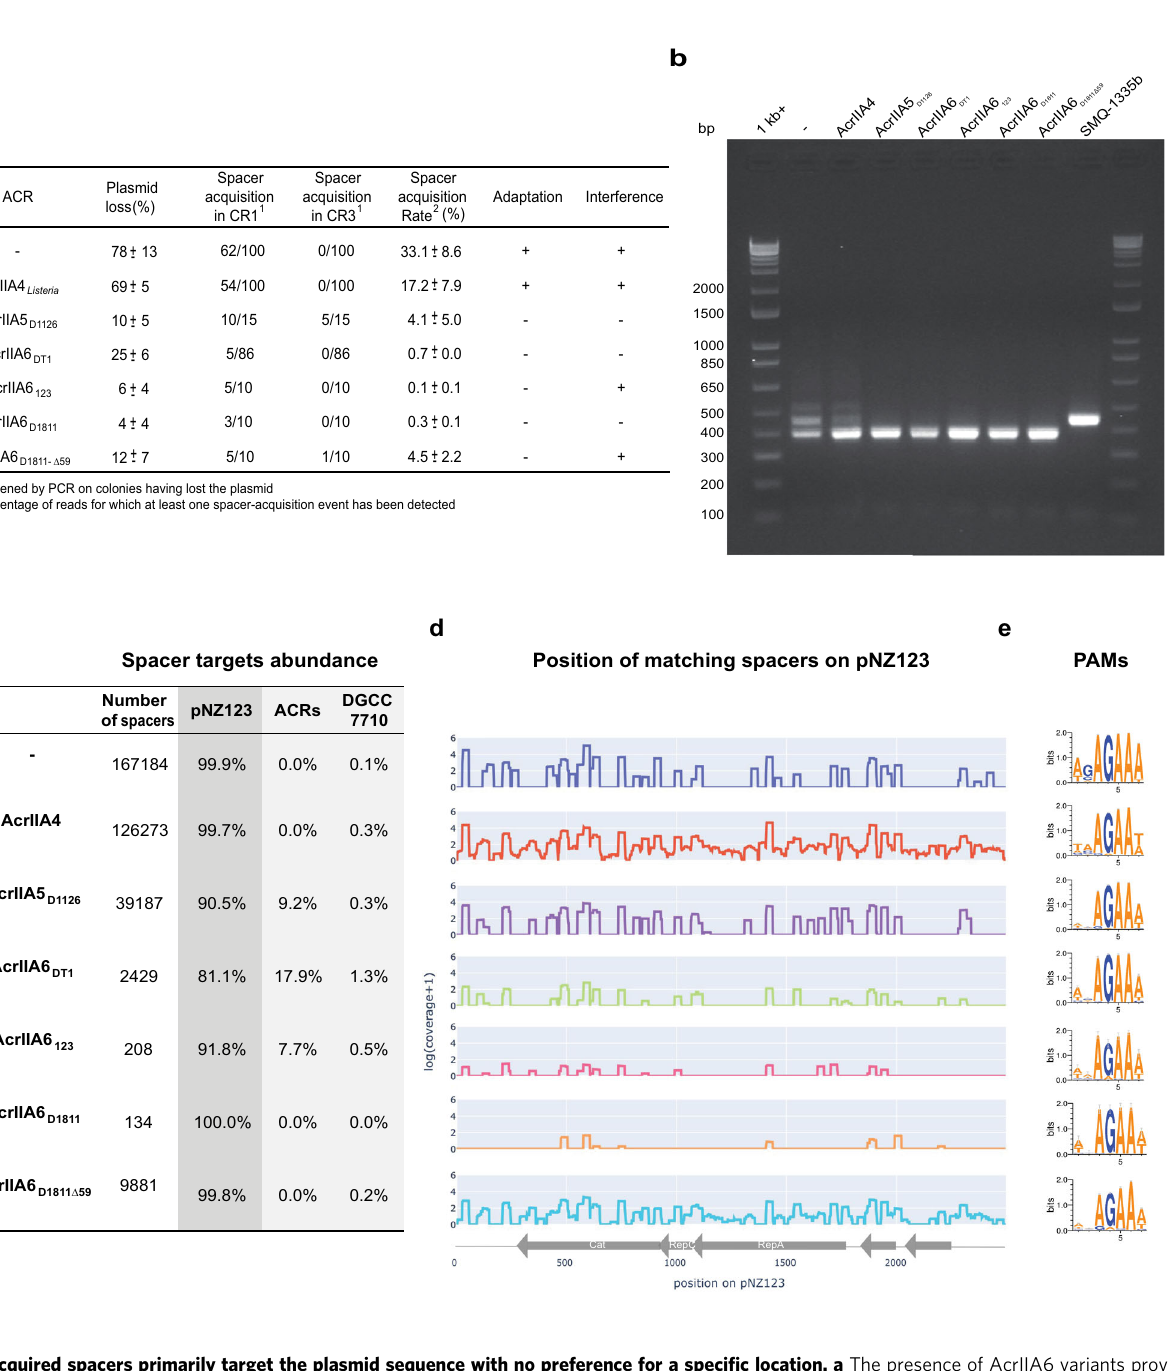
Fig. 3 Acquired spacers primarily target the plasmid sequence with no preference for a speci fi c location. a The presence of AcrIIA6 variants provides plasmid stability by inhibiting plasmid lost due to the type II-A CRISPR-Cas system. Spacer acquisition was evaluated by PCR on colonies that had lost the plasmid and by Illumina sequencing of the CR1 array at the end of the experiment, from two biological replicates. Truncated AcrIIA6 alleles maintained the plasmid and only a low level of spacer acquisition was detected. b PCR ampli fi cation of CR1 prior to Illumina sequencing on S. thermophilus cultures after 9 passages in the plasmid loss assay. c Relative abundance of spacers perfectly matching the plasmid, the acr gene, or the bacterial genome. d Spacers targeting the plasmid pNZ123 were mapped but no patterns were detected for target locations. e Seven nucleotides were extracted upstream from each spacer that targeted the plasmid sequence to identify the cognate PAMs for each condition and are represented using WebLogo. These results are from one biological replicate, the second replicate is shown in Figure